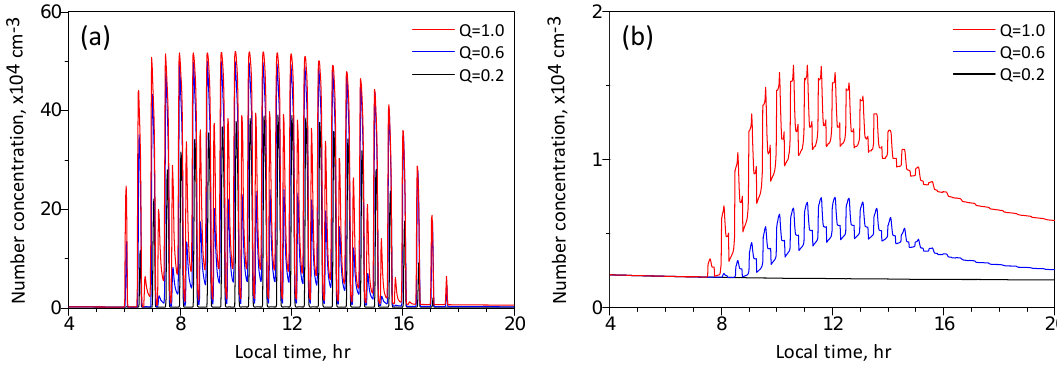
Fig. 7. Simulations of new particle production in air parcel moving in the form of large eddy circulation within the atmospheric boundary layer. The amplitude and period of the large eddy are set as 500m and 30min, respectively. The left panel shows the variation of D -all, and the right panel is for D > 10.